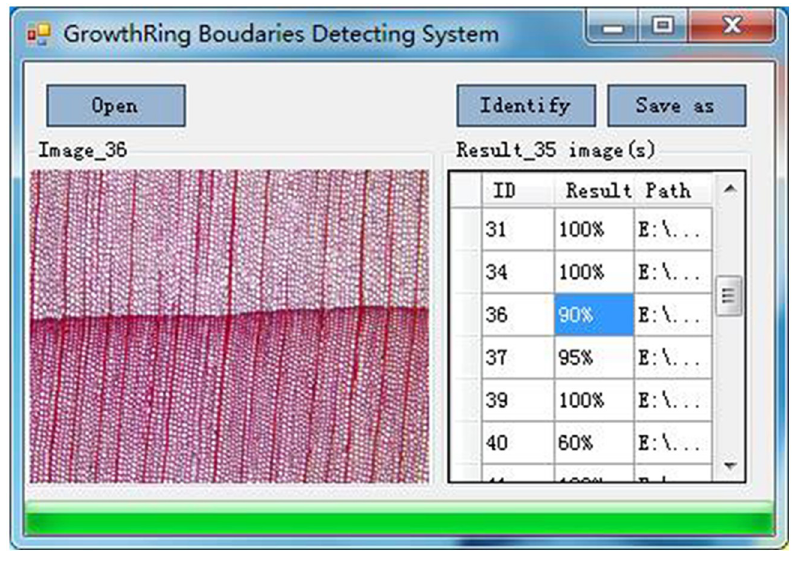
Fig 12. The interface of the